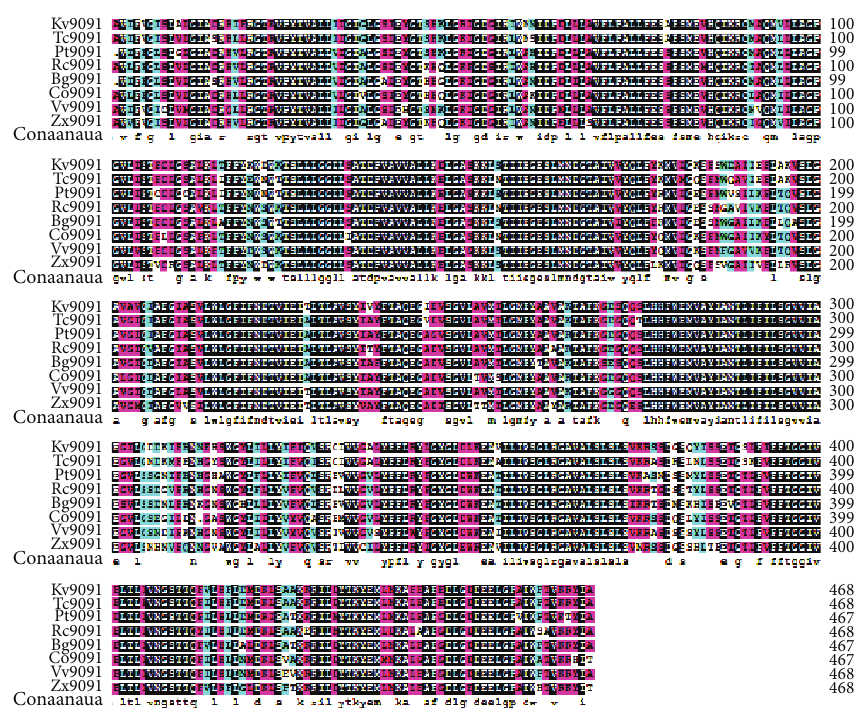
Figure 3: Alignment of KvSOS1 with other SOS1 homologues derived from Theobroma cacao (TcSOS1, EOY01238.1), Populus trichocarpa (PtSOS1, XP 002315837.2), Ricinus communis (RcSOS1, XP 002521897.1), Bruguiera gymnorrhiza (BgSOS1, ADK91080.1), Cucumis sativus (CsSOS1, XP 004150155.1), Vitis vinifera (VvSOS1, NP 001268140.1), and Zygophyllum xanthoxylum (ZxSOS1, ACZ57357.1). Identical peptides highlighted in black.